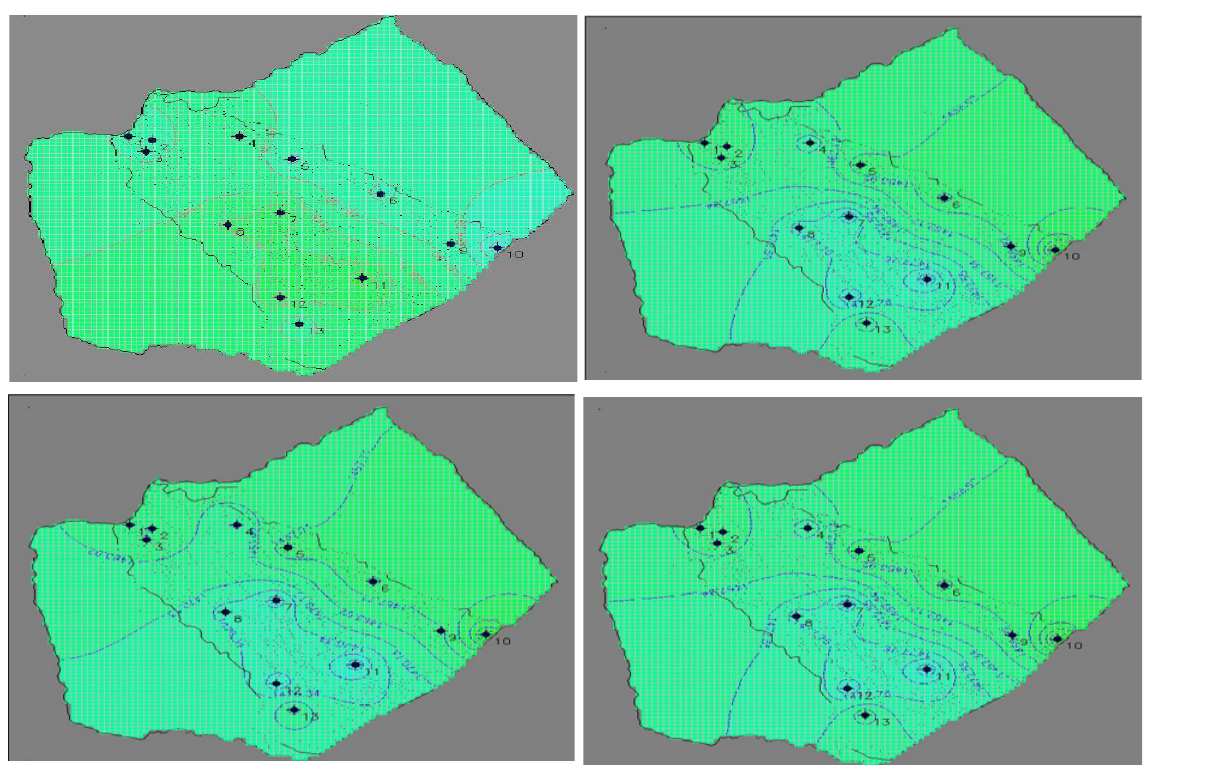
Figure 8. Plain hydraulic head contours using 25% runoff for four points Table 6. Changes in hydraulic head in observed wells (m) before and after recharge at 4 points in 2014-2015 Well No. After RechargeBefore